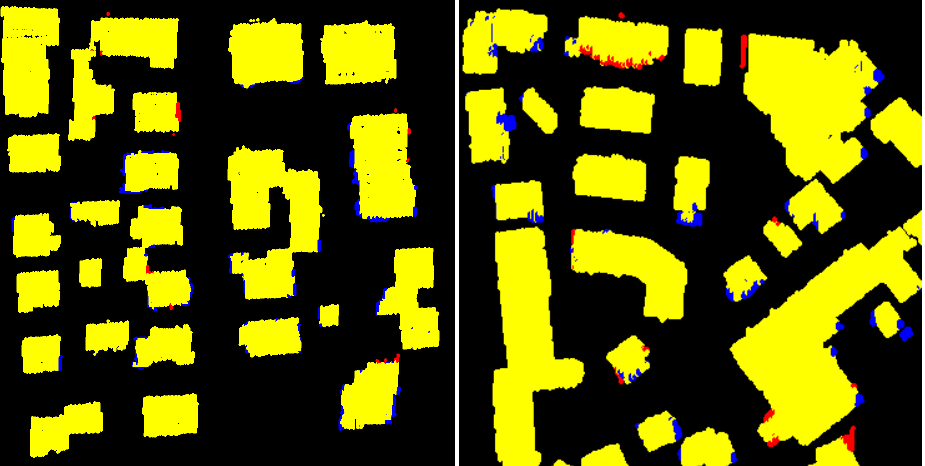
Figure 7: Evaluation of the building detection results on a per-pixel level (yellow: true positive, red: false positive, blue: false negative; left: part of test area 1, right: part of test area